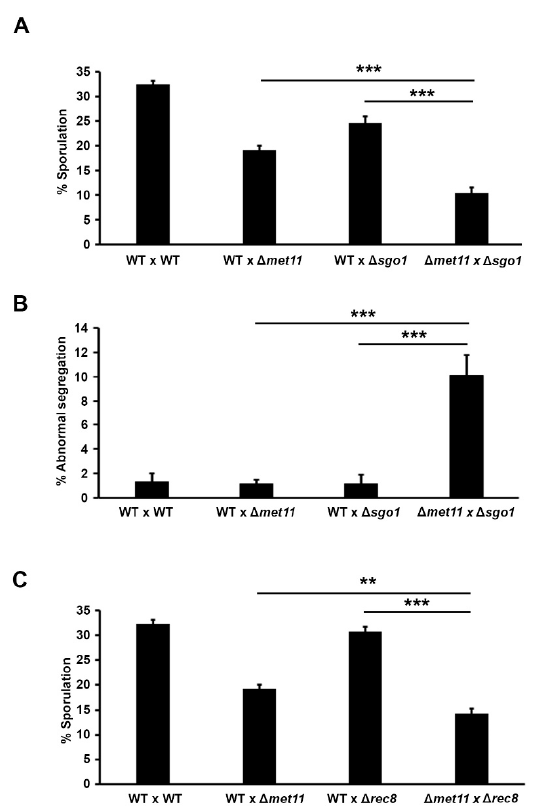
Figure 4. Met11 synergistically interacts with shugoshin and cohesin to govern proper meiosis. ( A ) Ascus formation frequency of WT × WT, WT × ∆ met11 , WT × ∆ sgo1, and ∆ met11 × ∆ sgo1 at 50 h after mating. n > 200. The result is the mean of three experiments. Error bar: S.D. ***: p < 0.001. ( B ) Genetic interaction of Met11 and Sgo1 on chromosome missegregation. Proportion of ascus containing abnormal (non-tetrad) number of nuclei was counted at 50 h after mating by microscopic observation of DAPI-stained cells. Crosses were WT × WT, WT × ∆ met11 , WT × ∆ sgo1 , and ∆ met11 × ∆ sgo1 . n > 200. Result represent mean of three experiments. ***: p < 0.001. ( C ) Ascus formation frequency of WT × WT, WT × ∆ met11 , WT × ∆ rec8 and ∆ met11 × ∆ rec8 at 50 h after mating. n > 200. Bars and error bars represent the mean and S.D. of three experiments. **: p < 0.01, ***: p < 0.001.